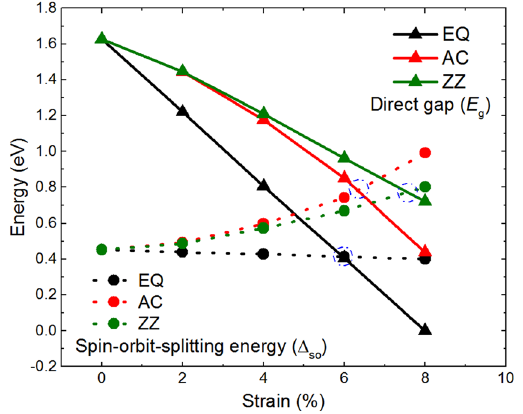
Figure 4. Calculated direct gap ( E g ) and spin-orbit-splitting energy ( Δ so ) at Γ point of stanane as fractions of biaxial strain along EQ direction, uniaxial strain along AC and ZZ directions. The solid and dash lines represent E g and Δ so ,